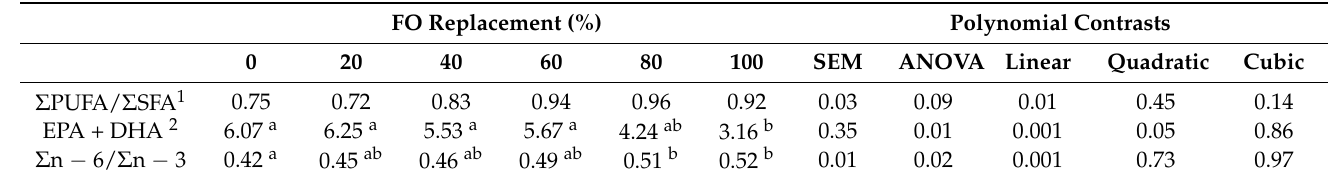
Table 8. Nutritional indices of the whole body of juvenile tench fed practical diets with different replacements of cod liver oil (FO) with camelina oil (CO). FO Replacement (%) Polynomial